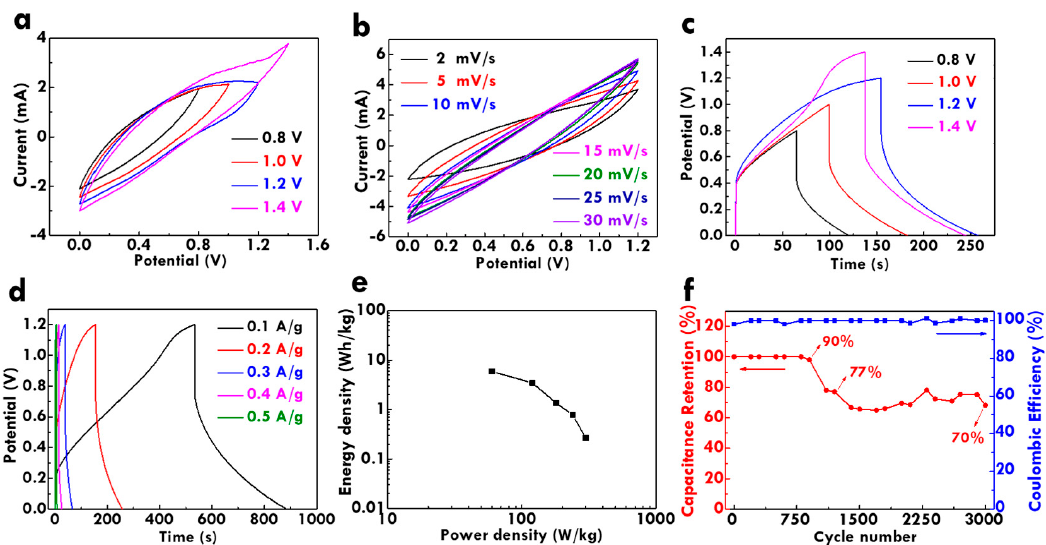
Figure 6. The CV curves ( a ) with different potential windows at 2 mV/s and ( b ) at different scan rates with the potential window of 1.2 V; the GC/D curves ( c ) with different potential windows at 0.2 A/g and ( d ) at different current densities with the potential window of 1.2 V; ( e ) Ragone plots and ( f ) the relation of the C L value and the Coulombic efficiency to the cycle number in 3000 charge/discharge cycles for the fiber-type supercapacitors (FSC) at 0.2 A/g in the H 3 PO 4 /PVA gel electrolyte.